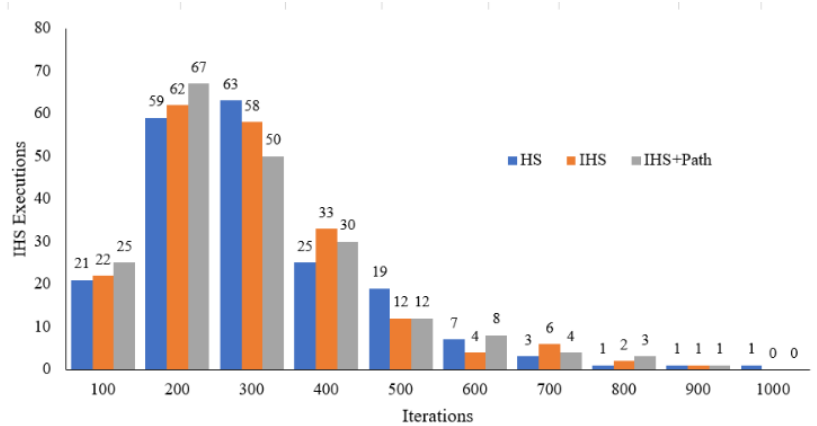
Figure 5. Convergence frequency of different algorithms for the 33-bus test system.